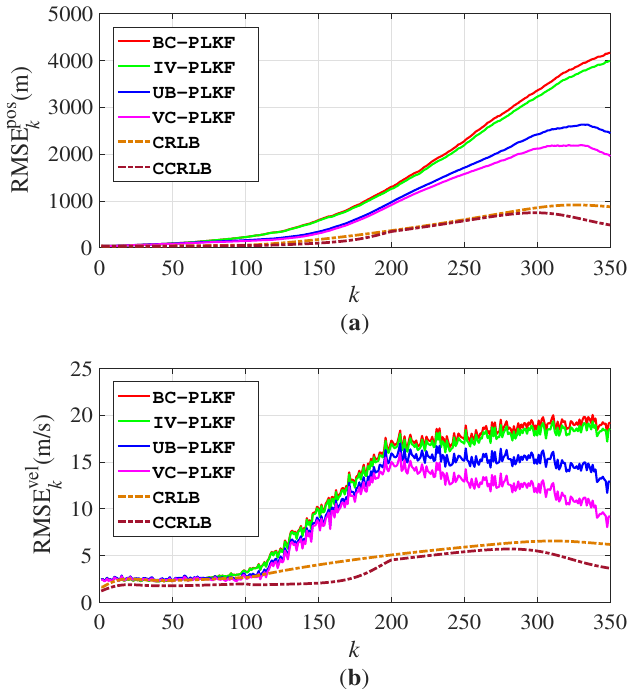
Figure 5. RMSEs for different algorithms in manoeuvring target tracking: ( a ) RMSEs for position; ( b ) RMSEs for